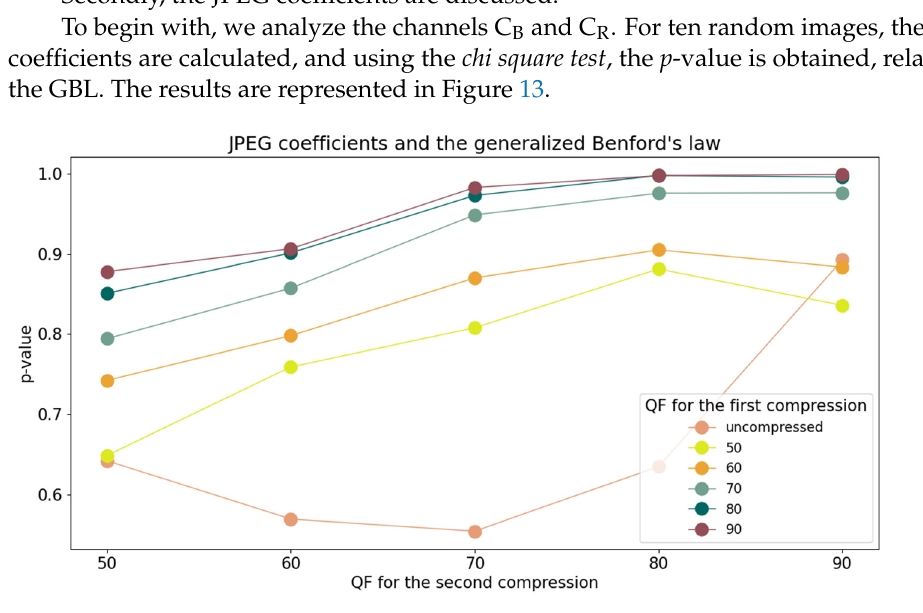
Figure 13. The JPEG coefficients compared to the GBL, using the C B channel.